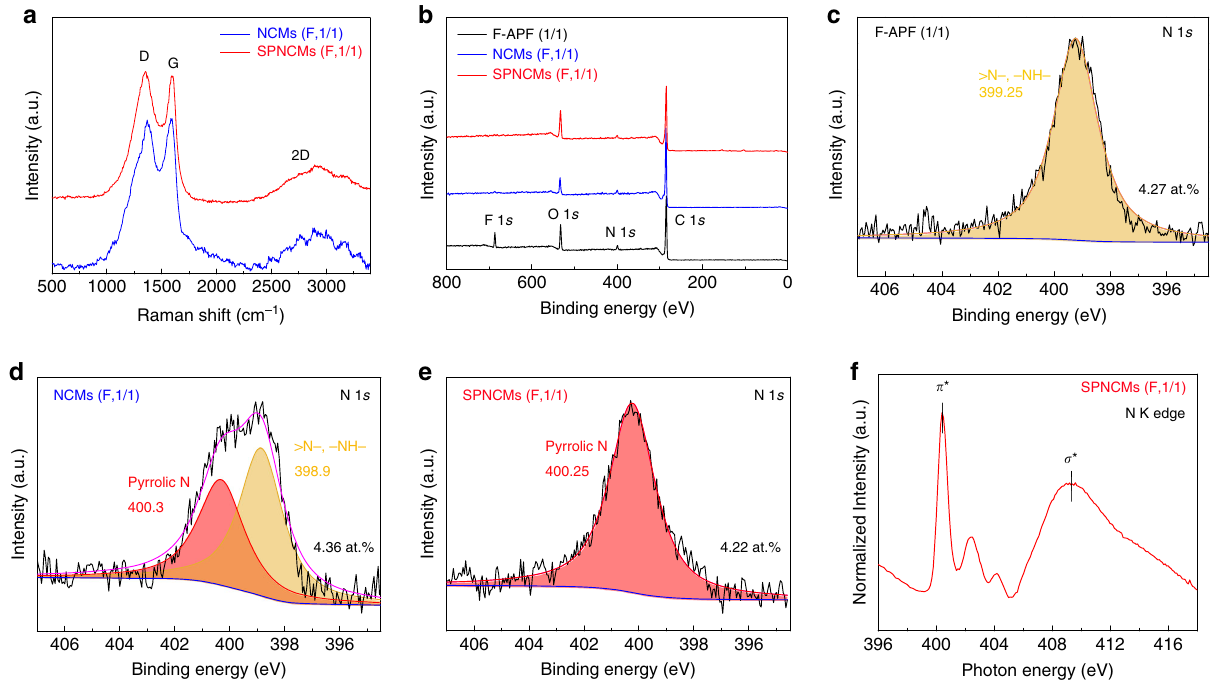
Fig. 2 Structural characterization of the samples. a Normalized Raman spectra of the NCMs (F, 1/1) and SPNCMs (F, 1/1). b XPS survey spectra of the F- APF resin (1/1), NCMs (F, 1/1), and SPNCMs (F, 1/1). High-resolution N 1 s XPS spectra of c the F-APF resin (1/1), d NCMs (F, 1/1), e SPNCMs (F, 1/1). f N K edge XAFS spectrum of the SPNCMs (F, 1/1) (the test was performed in the total electron yield (TEY)